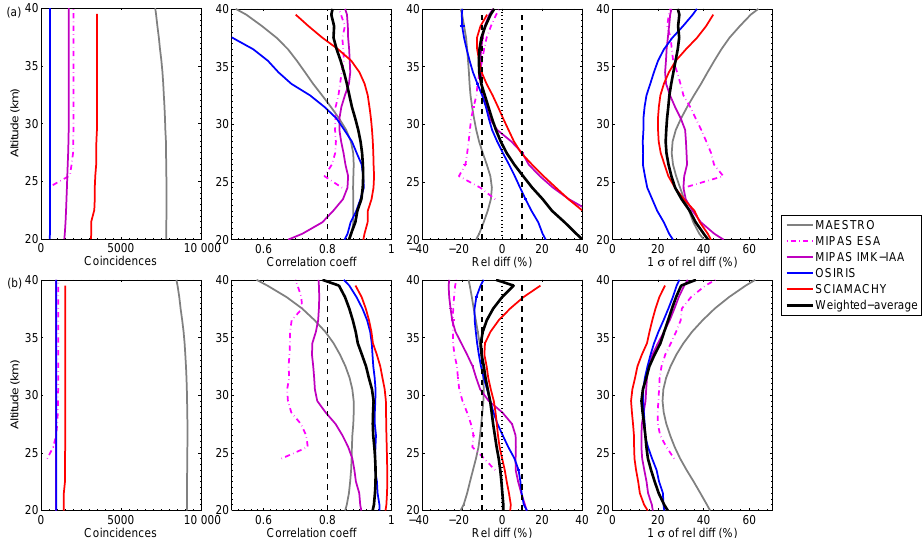
Figure 8. Comparisons of ACE-FTS NO 2 profiles with correlative data sets using coincidence criteria of within 4h and 350km: (a) compar- isons for local morning and (b) local evening. Note that GOMOS and the solar occultation instruments have been excluded. Error bars in the relative difference profiles represent the standard error of the mean (values less than ∼ 1% may not be